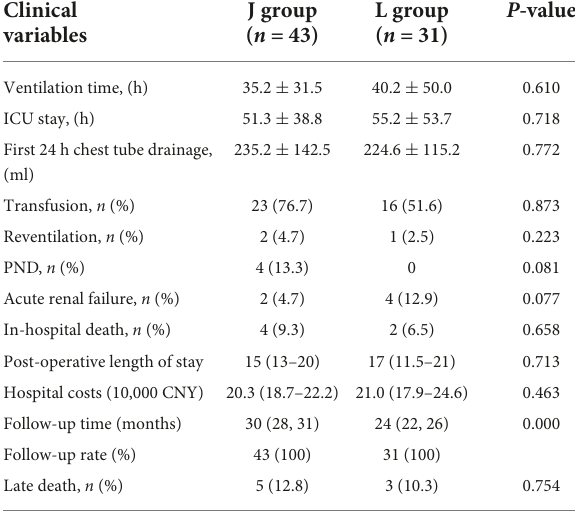
TABLE 3 Post-operative data of